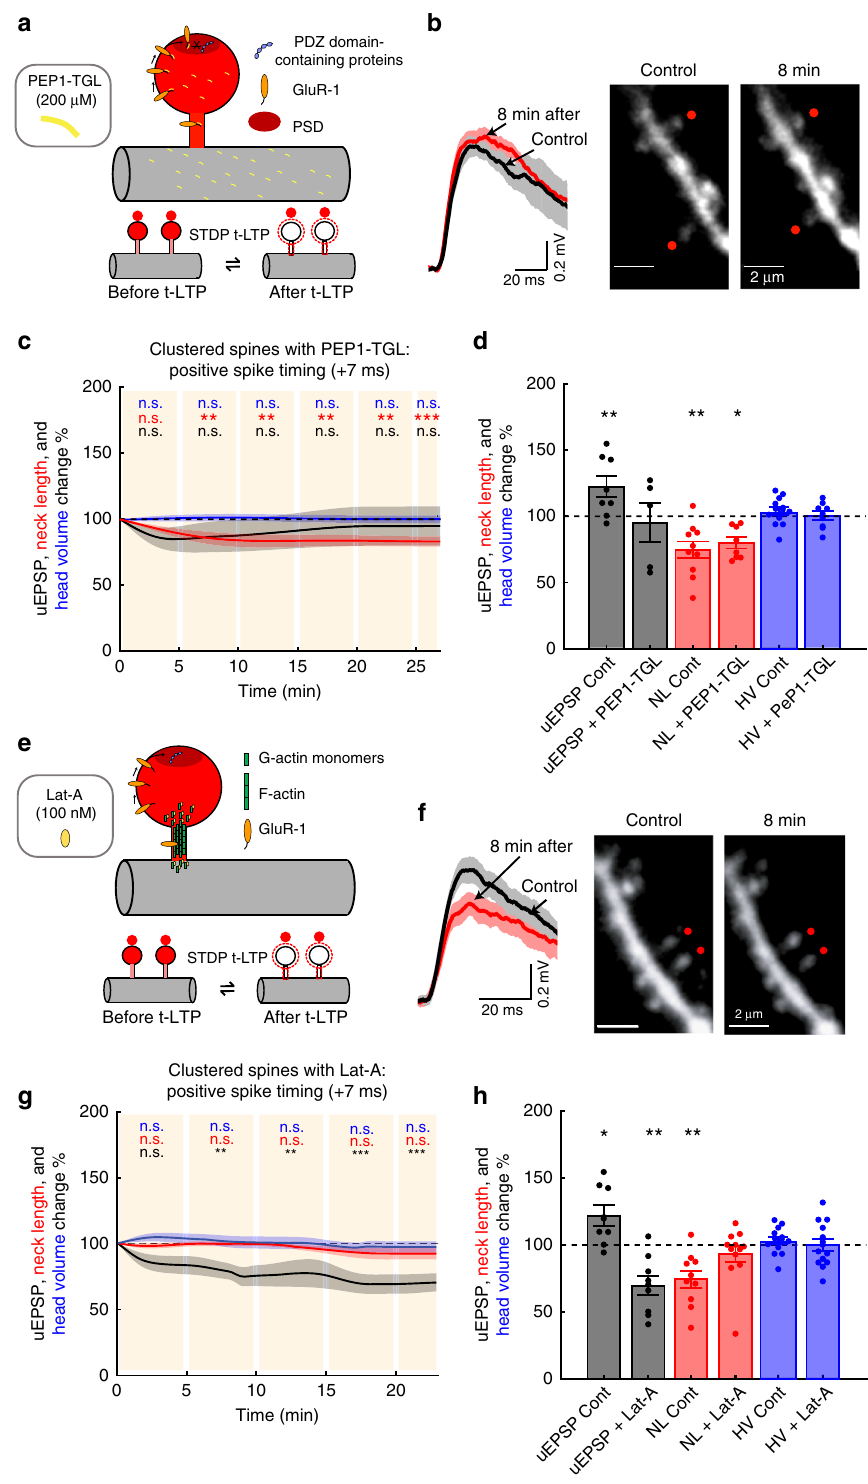
cellular permeation) added to the bath 32 completely blocked the prevents it from entering the cell), we observed no inhibition of the shrinkage of the activated spine necks ( P = 0.35, n = 9 spine pairs, increase in uEPSP amplitude and shrinkage of the neck of the Fig. 4f – h, Supplementary Fig. 2b) and the increase in uEPSP activated spines (Supplementary Fig. 8a – c). amplitude, inducing instead a signi fi cant reduction in uEPSP No signi fi cant difference was observed between initial uEPSP amplitude over time ( P < 0.001, Fig. 4f – h, Supplementary Fig. 2b). amplitudes for pre – post pairing protocols of + 7 ms with versus However, when the t-LTP induction protocol was performed with without Lat-A (uEPSP: 0.66 ± 0.1 versus 1.16 ± 0.28 mV, P = 0.15, Mann – Whitney test, Supplementary Fig. 4). The lack of rundown NATURE COMMUNICATIONS| (2020) 11:4276